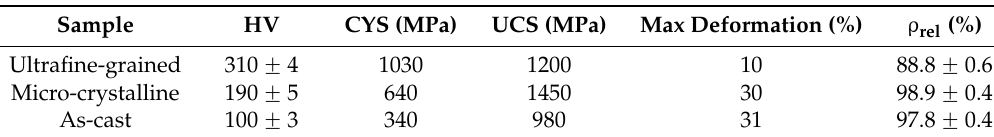
Table 1. Vickers hardness (HV), compressive yield strength (CYS), ultimate compressive strength (UCS), maximum deformation and relative density ( ρ rel ) of bulk samples.